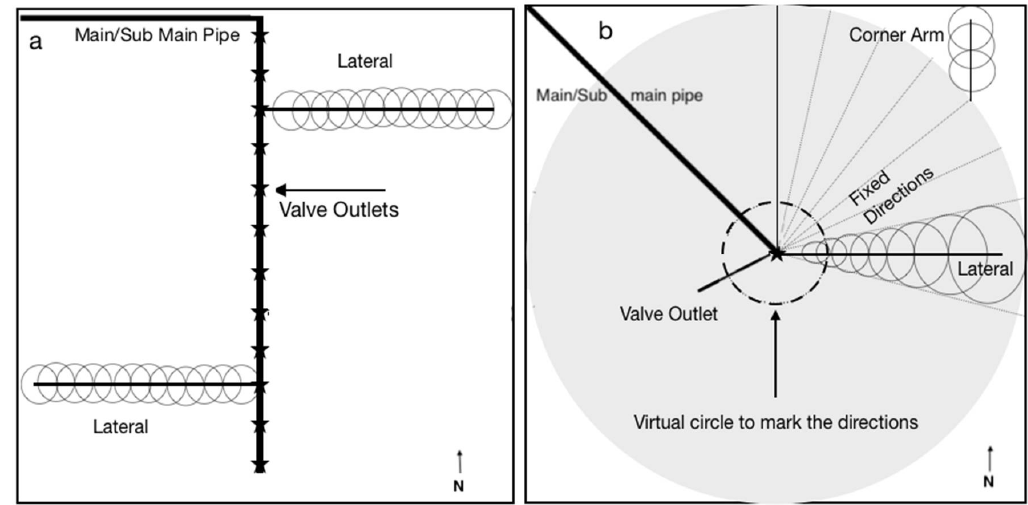
Figure 1. Schematic semi-permanent split lateral ( a ), and CHL irrigation system ( b ) comparison.